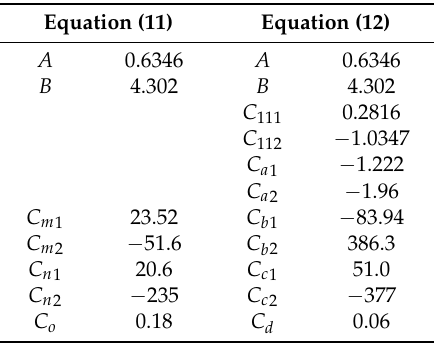
Table 6. Coefficients in Equation (9) for ASTER SW channels.